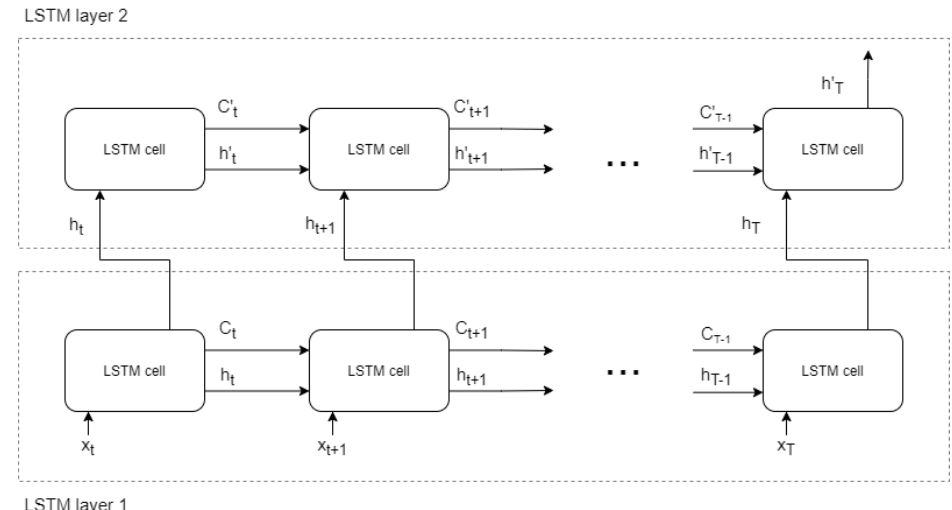
Figure 5. Scheme for an unrolled LSTM with two